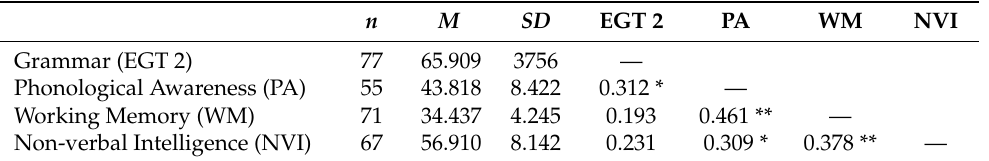
Table 5. Descriptive statistics and